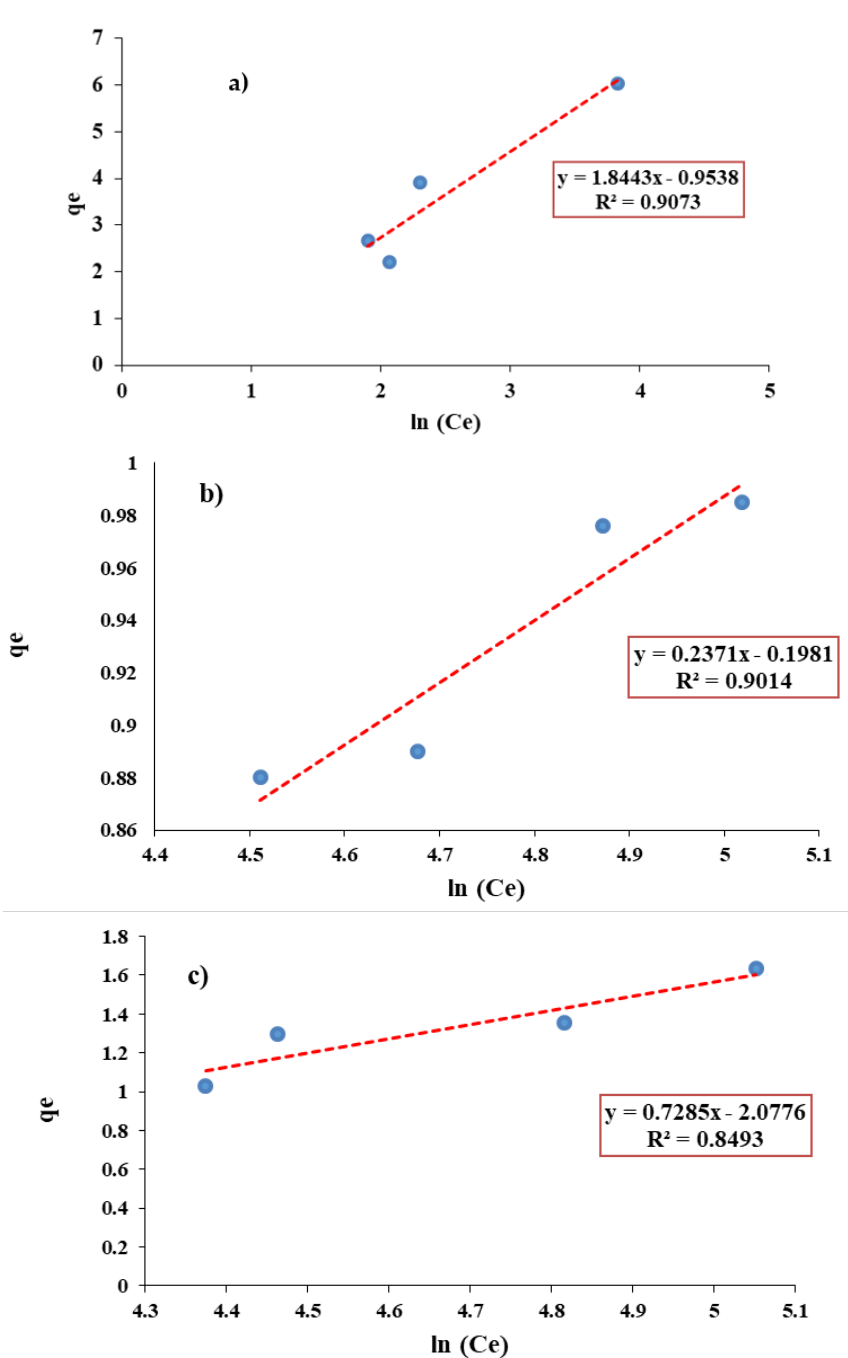
Figure 17. Linear form of Temkin isotherm model for the adsorption of calcium ions by ( a ) zeolite, ( b ) activated carbon, and ( c ) activated alumina.